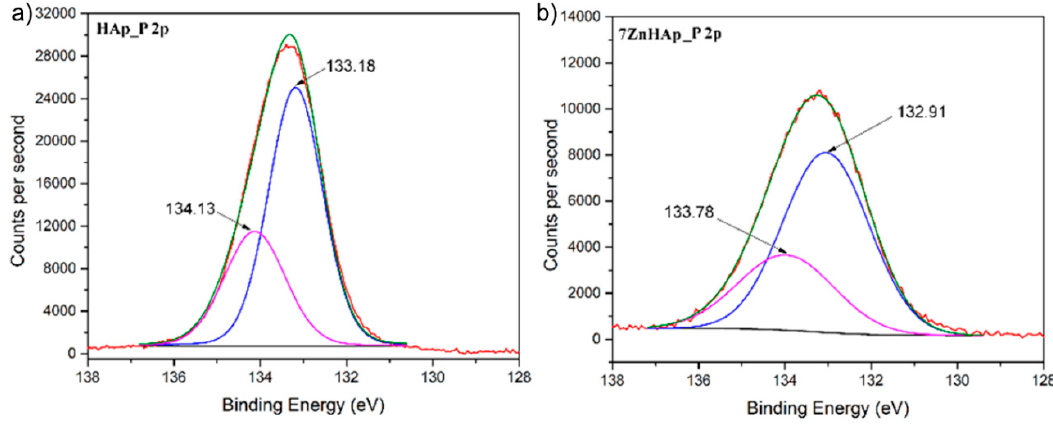
Figure 6. The high-resolution XPS spectra for P 2p of Hap ( a ) and 7HApZn samples ( b ).